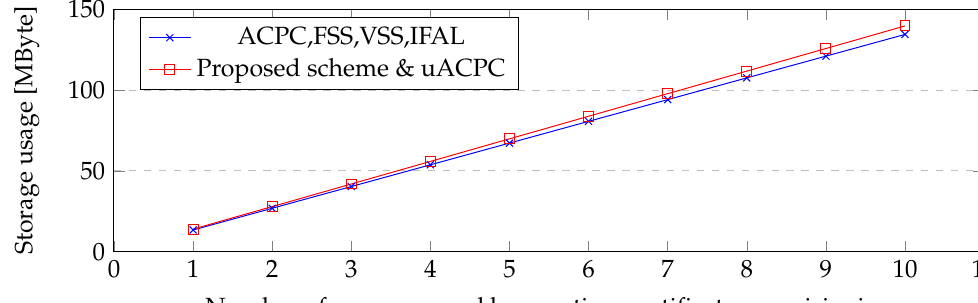
Figure 8. Storage usage in the